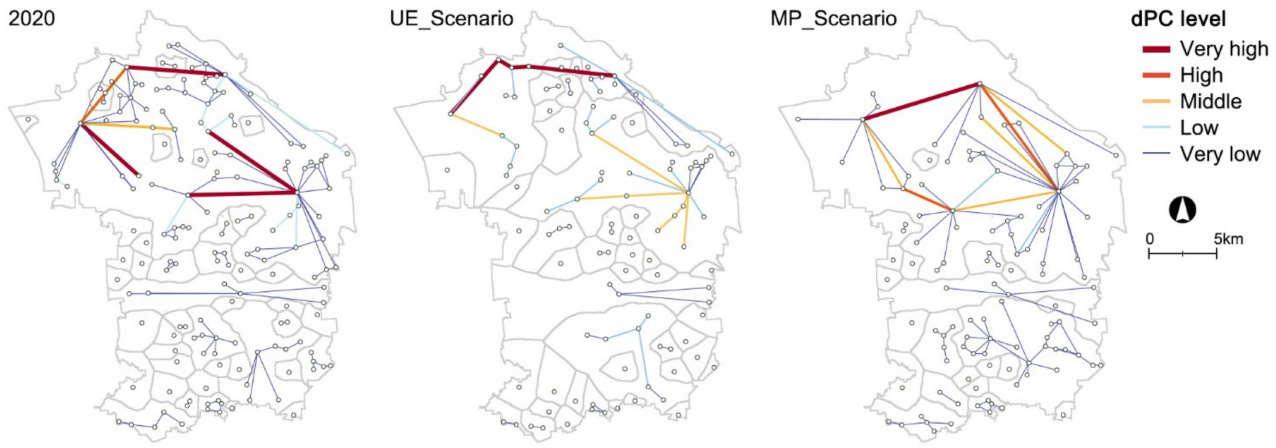
Figure 4. dPC level of corridors in 2020 and under two